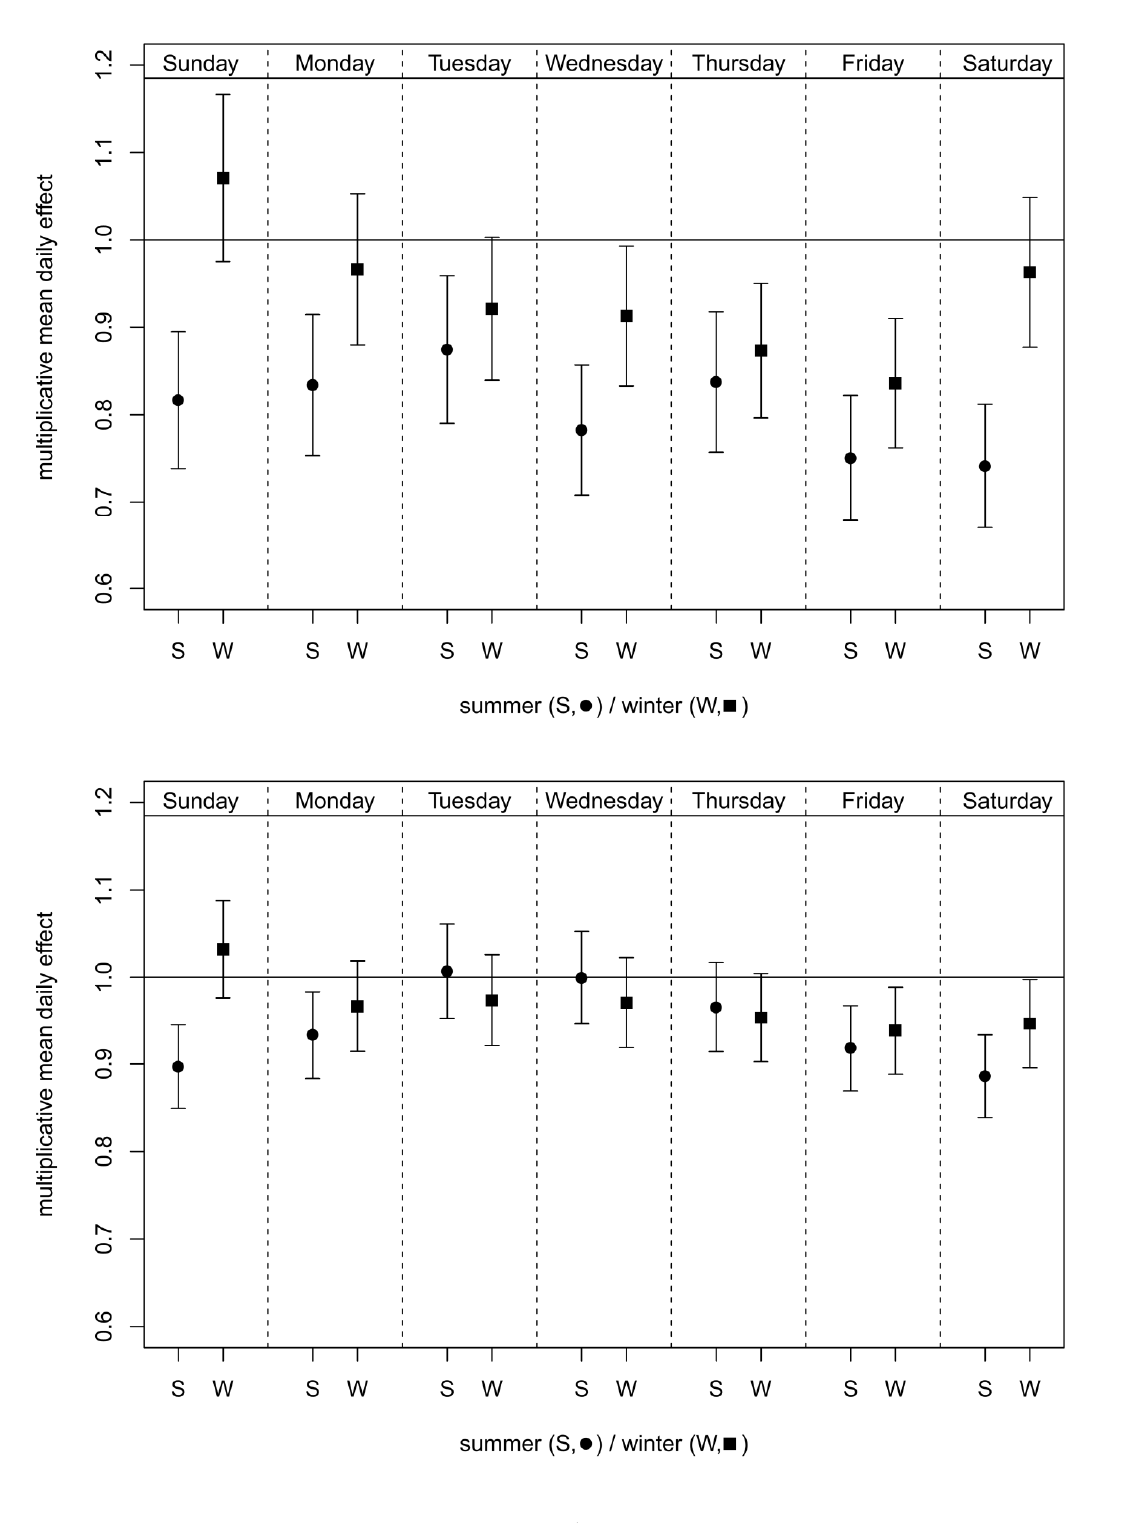
Figure 4. Mean daily effects of the measures stratified by season and day of the week with 95% confidence intervals for Prinzregentenstrasse ( above ) and Lothstrasse ( below